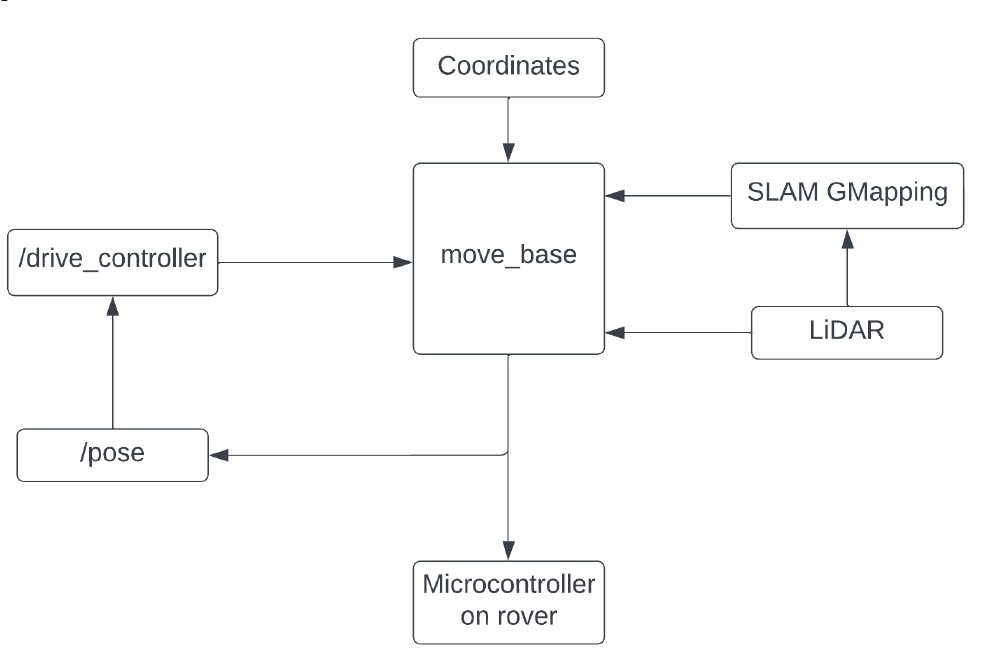
Figure 4. Navigation stack of the